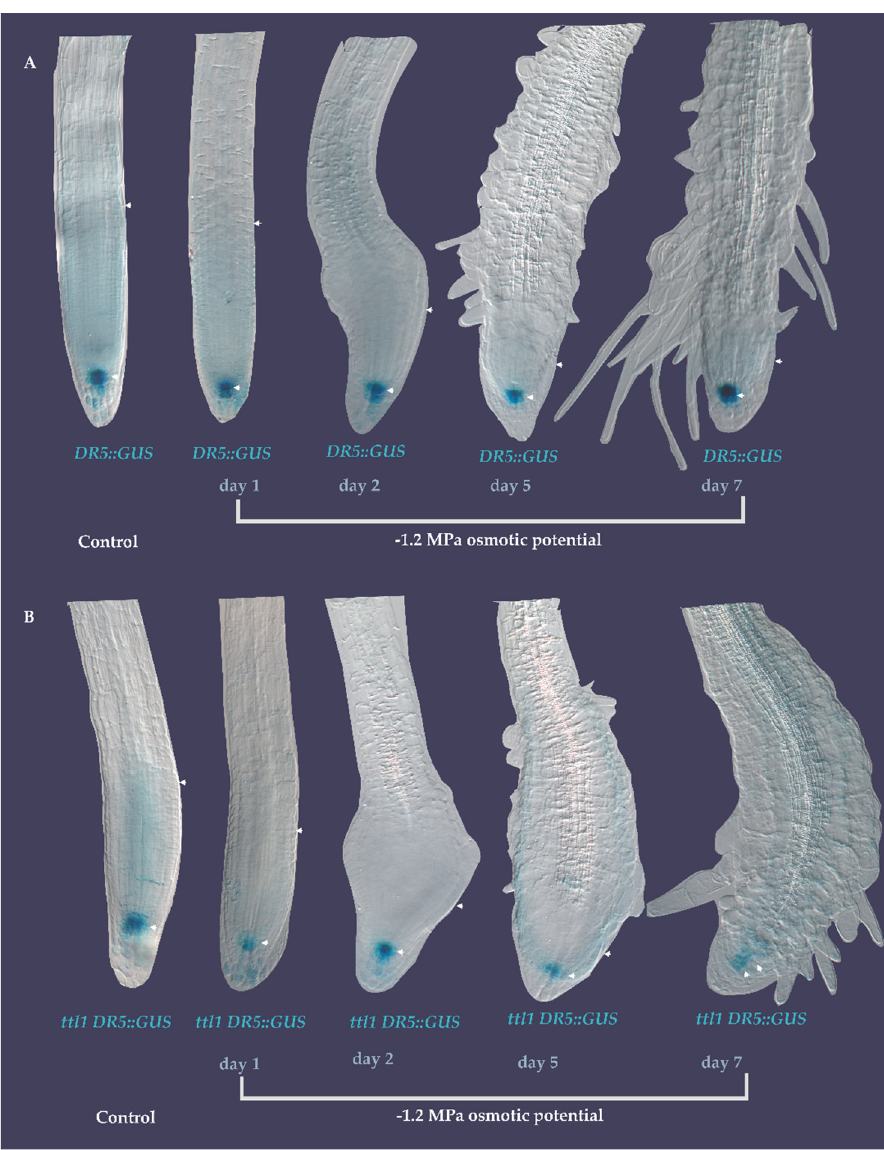
Figure 7 . Expression pattern of auxin in response to 7 days of severe osmotic stress. ( A ) DR5::GUS in Col-0 in control medium and during 7 days of severe osmotic stress showing localization in the QC. ( B ) DR5::GUS in ttl1 mutant showing the same localization as in Col-0. Arrowheads indicate the size of the PM (from the QC to the TZ).